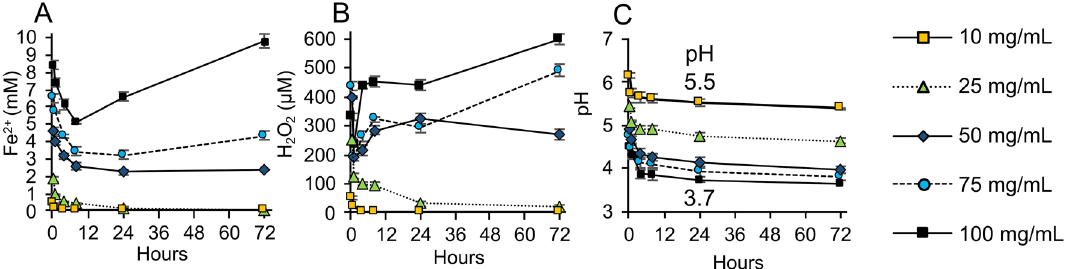
Figure 2. Ferrous iron release, ROS generation and pH buffering. All experiments were performed with a mineral mixture containing 95 wt. % smectite and 5% pyrite, exchanged with 30 mM FeSO 4 . (A) Concentrations of Fe 2+ released from different doses of minerals (10–100 mg/mL) in TSB media over 72 h. (B) Concentrations of H 2 O 2 released from minerals in TSB media over 72 h. (C) Changes in pH over 72